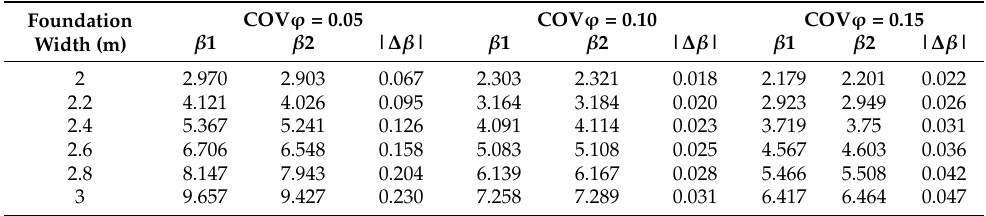
Table 7. Comparison of the results of ULS reliability analyses with different numbers of random variables.